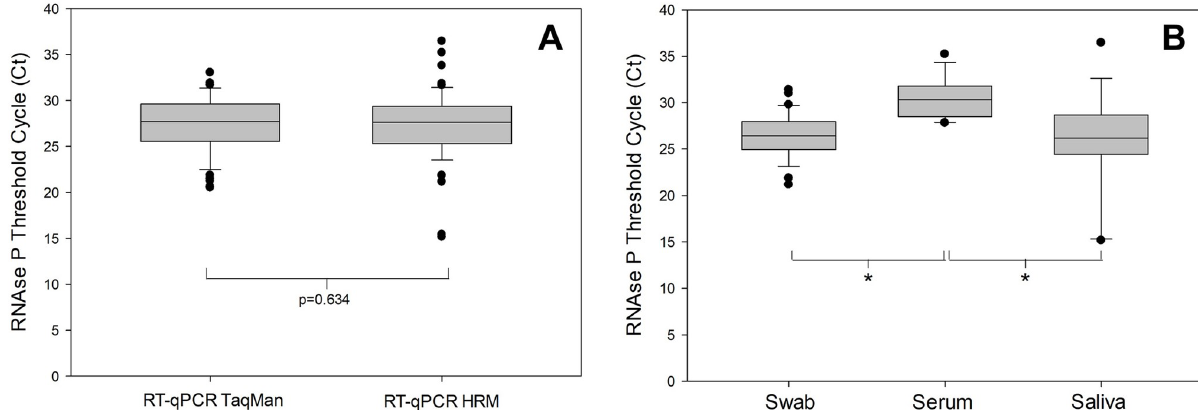
Fig 3. Boxplot of RNAse P Ct values between RT-qPCR TaqMan and RT-qPCR HRM assays and between swab, serum and saliva samples. The Ct values for the amplification of the internal control, human RNAse P, between TaqMan and HRM assays were compared between all the collected clinical specimens (A) or between swab, serum and saliva samples (B). The outliers are represented as the black circles. In A, p = 0.634 (Mann-Whitney Rank Sum Test). In B, � P < 0.05 (One-way ANOVA) and p = 1.00 (Swab x Saliva—Mann-Whitney Rank Sum Test).